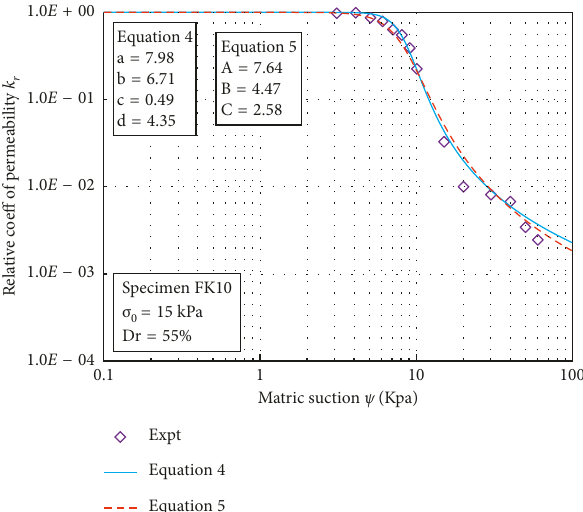
Figure 7: Permeability coefficient changes against matric suction for soil FK20.